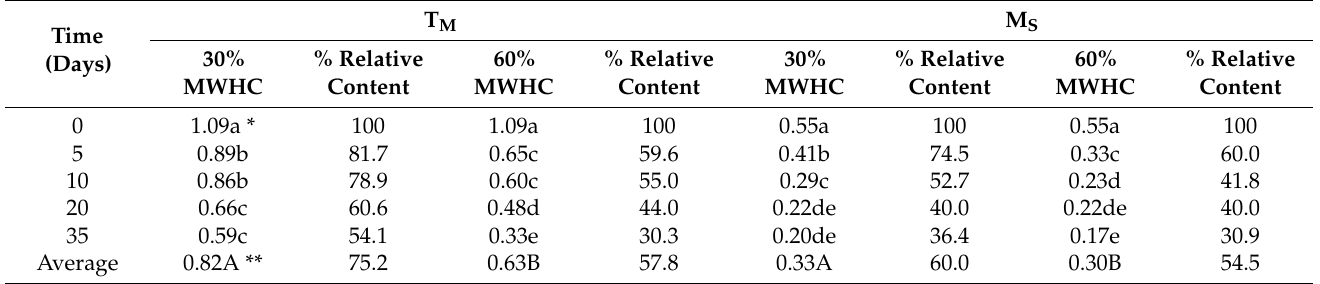
Table 5. Effect of incubation time and soil moisture on the release rate of ammonium from organic fertilizers (%N in dry mass). Time